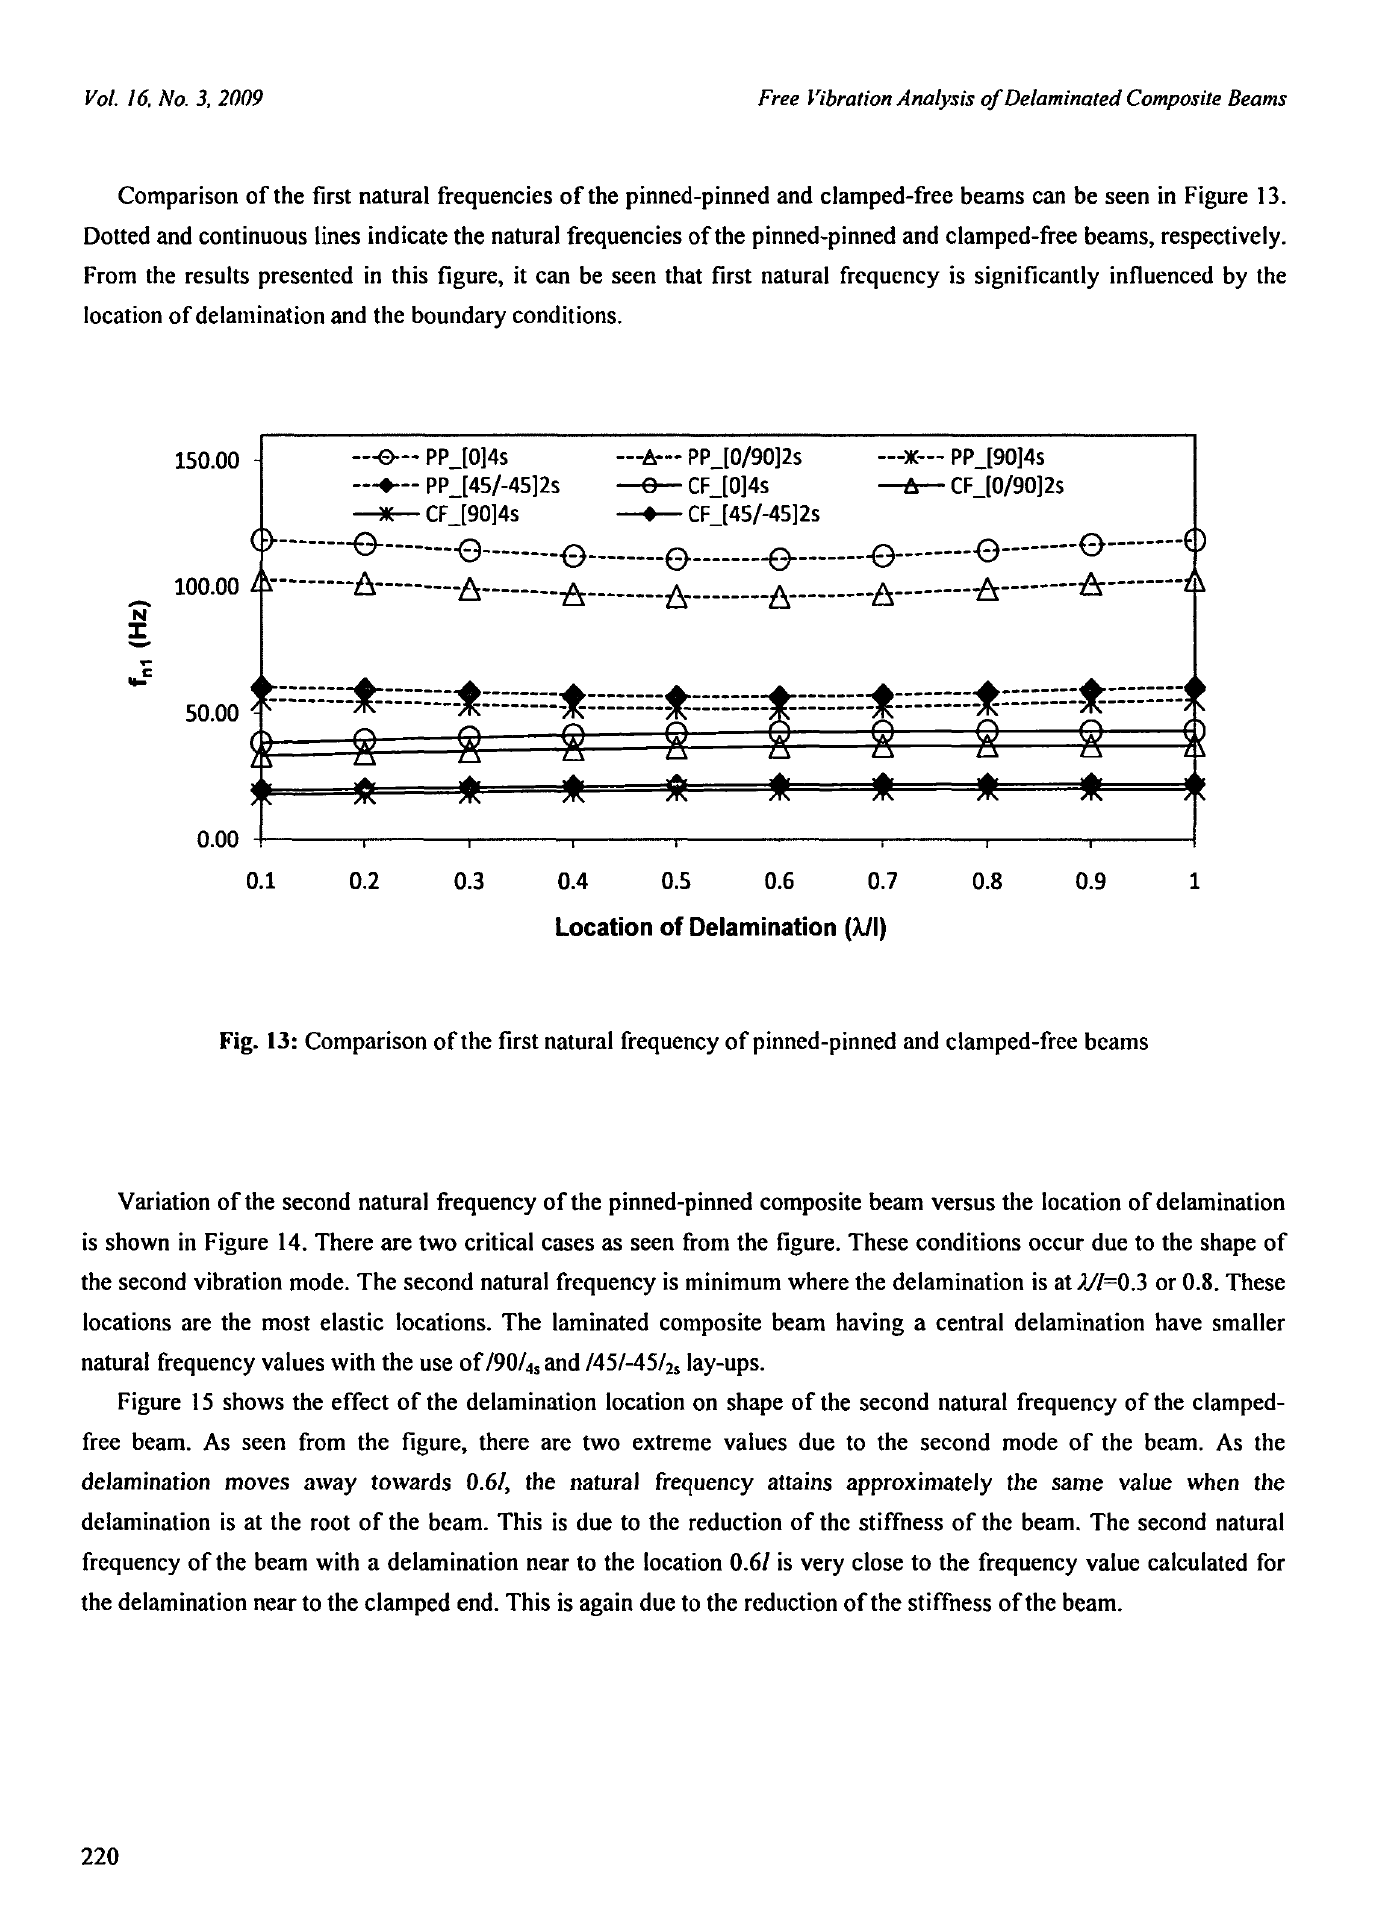
Variation of the second natural frequency of the pinned-pinned composite beam versus the location of